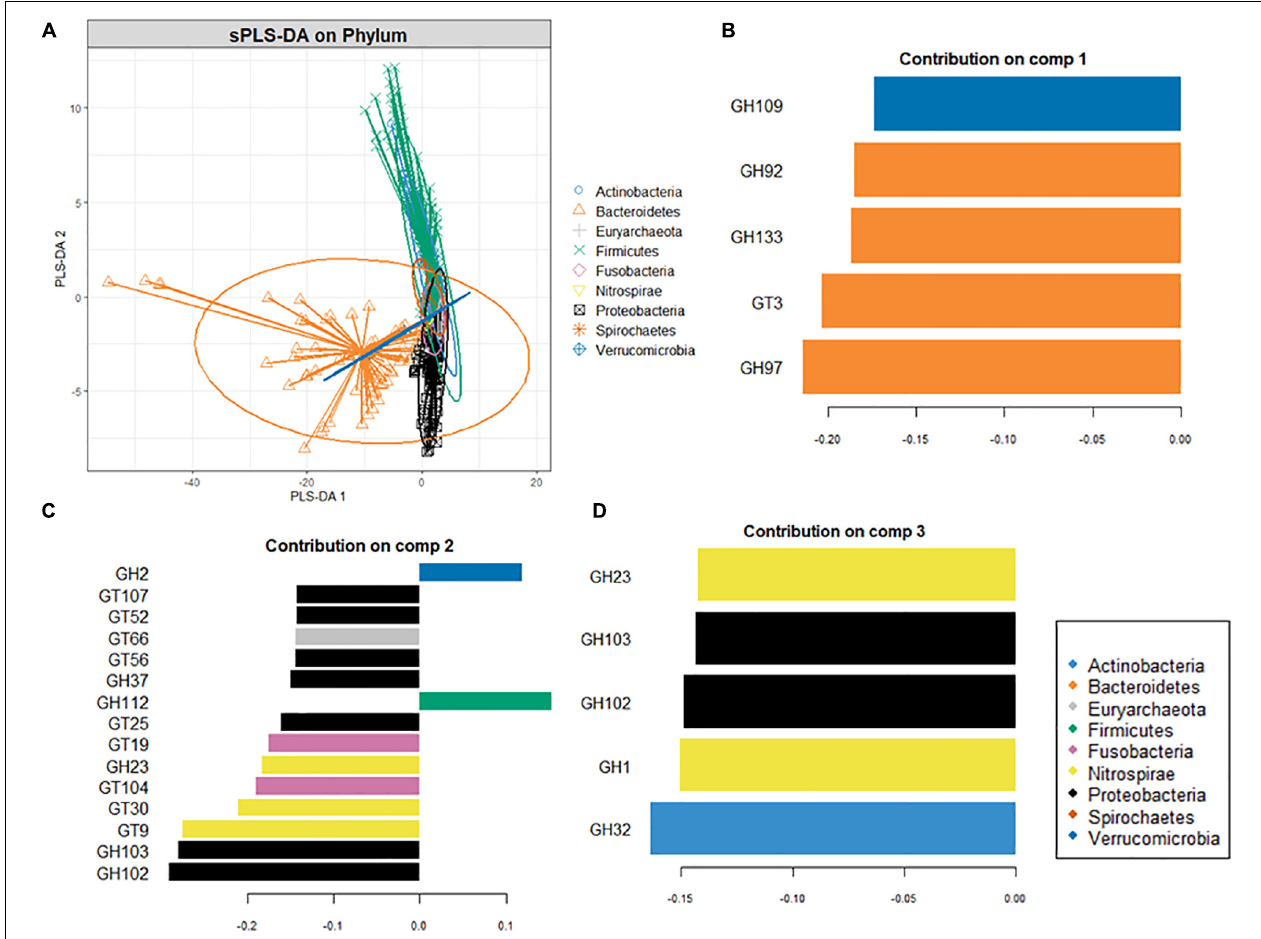
FIGURE 4 | Supervised analysis and feature selection with sparse PLS-DA. (A) Sample plots showing clustering of the CAZyme abundance at the phylum level with 95% confidence ellipses. (B,C) Loading weights of the most important variables selected on component 1 (B) , component 2 (C) , and component 3 (D) . Fill colors indicate the phylum in which the CAZyme is most abundant. Only the top ten CAZymes are displayed in panel (B) while (A,C) five CAZymes on which the model was